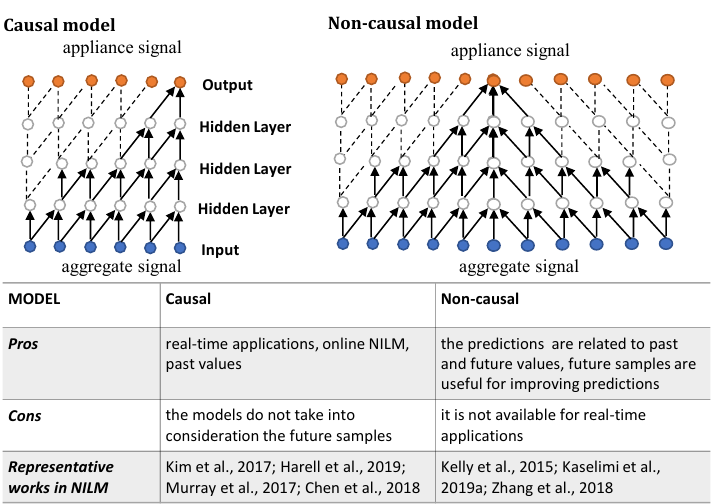
Figure 7. The advantages and disadvantages of the causal and non-causal NILM models